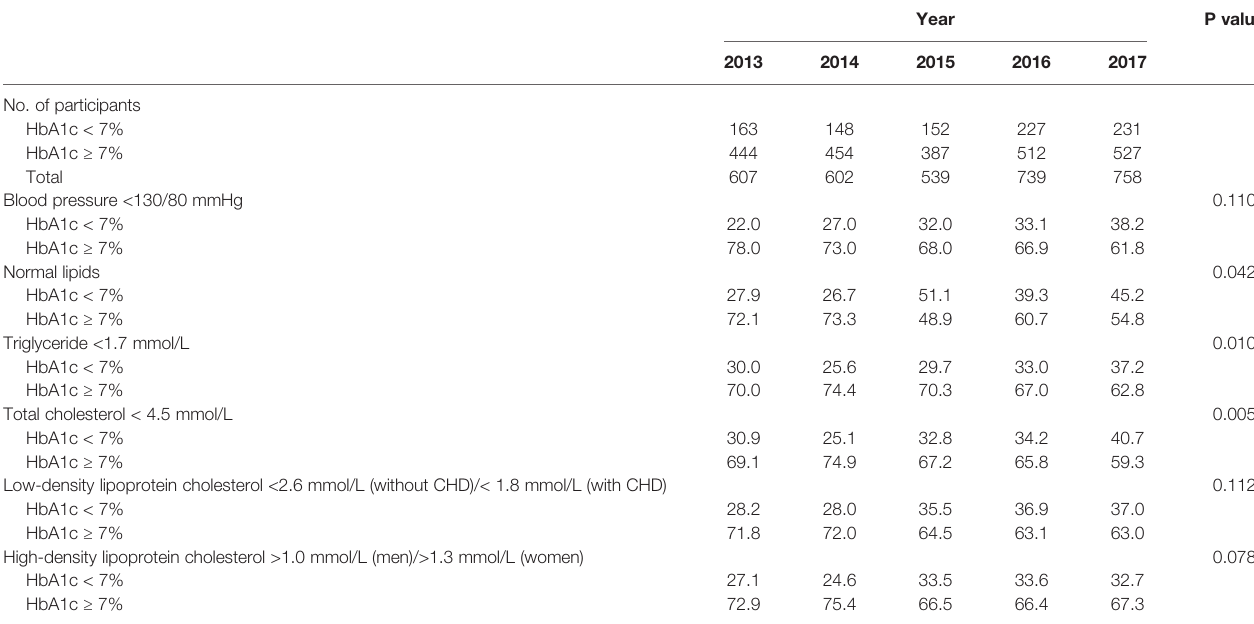
TABLE 6 | Prevalence of HbA1c below and above 7% among inpatients with type 2 diabetes attaining the Chinese Diabetes Society goals for Prevention and Treatment of Diabetes from 2013 to